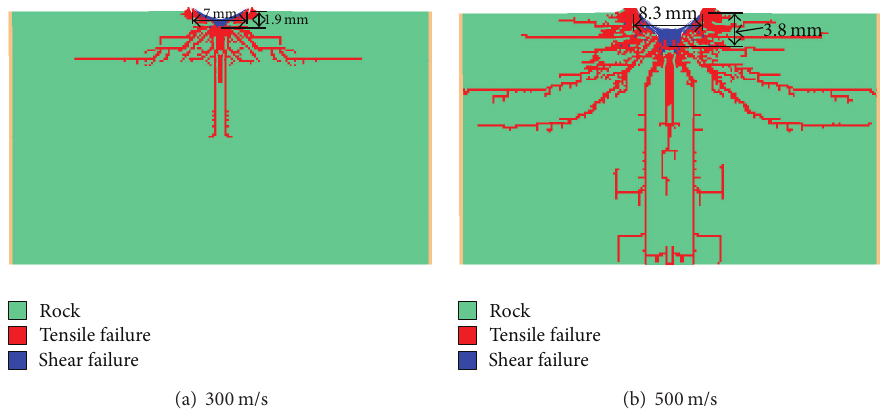
Figure 11: Rock fragmentation status at different impact